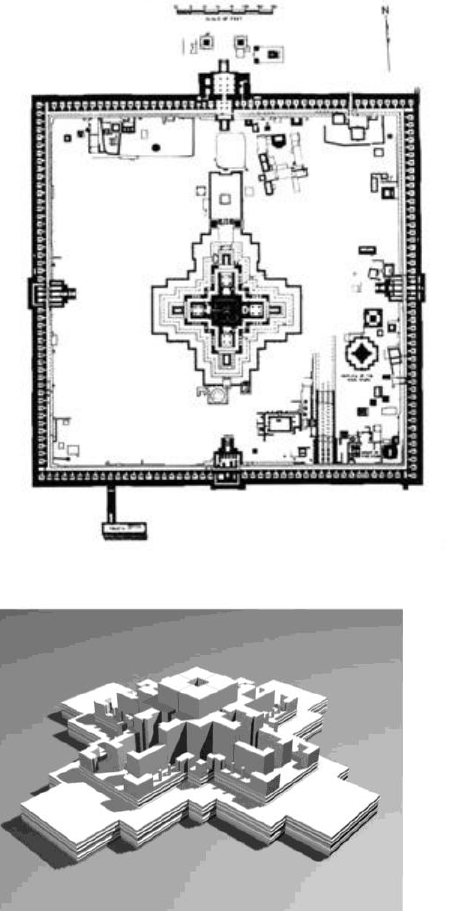
Fig.1: Plan of Sompur Mahavihara (Source: Department of Archaeology, Govt. Of Bangladesh) and the reconstructed model of the central structure (Rashid